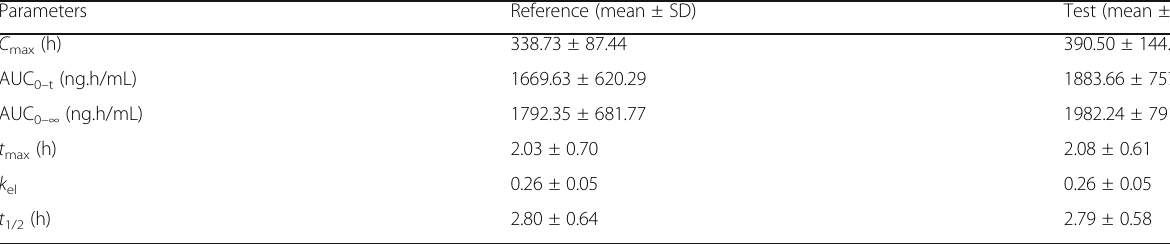
Table 5 Mean pharmacokinetic parameters of lenalidomide in 12 human volunteers